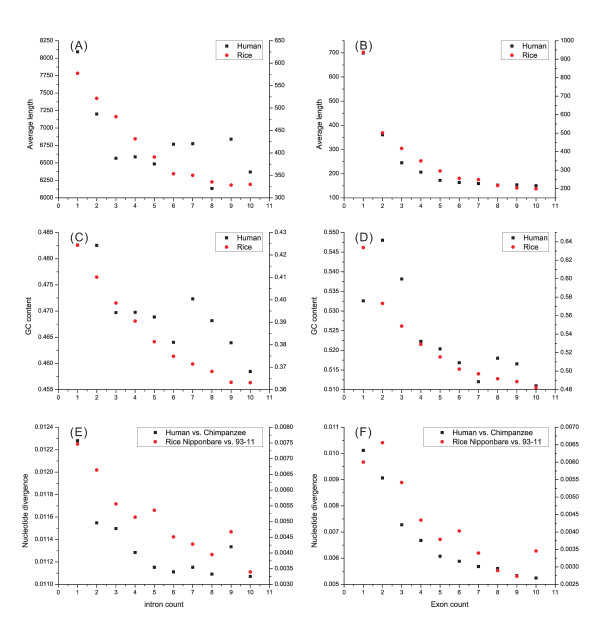
Correlations between the length and intron (A) or exon (B) count, between GC content and intron (C) or exon (D) count and between the nucleotide divergence and intron (E) or exon (F) count. The number (count) in the horizontal axis stands for the 1, 2-,..., 9 and 10-intron (or -exon) genes.